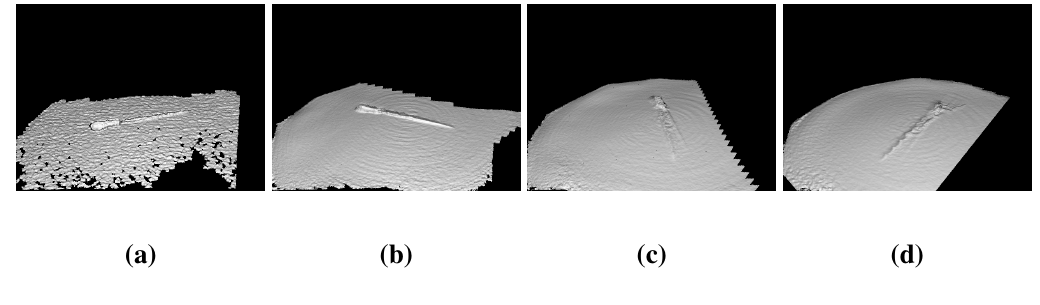
Figure 16. Different moments of the tool reconstruction with KinectFusion. The objects is mixed progressively with the floor.